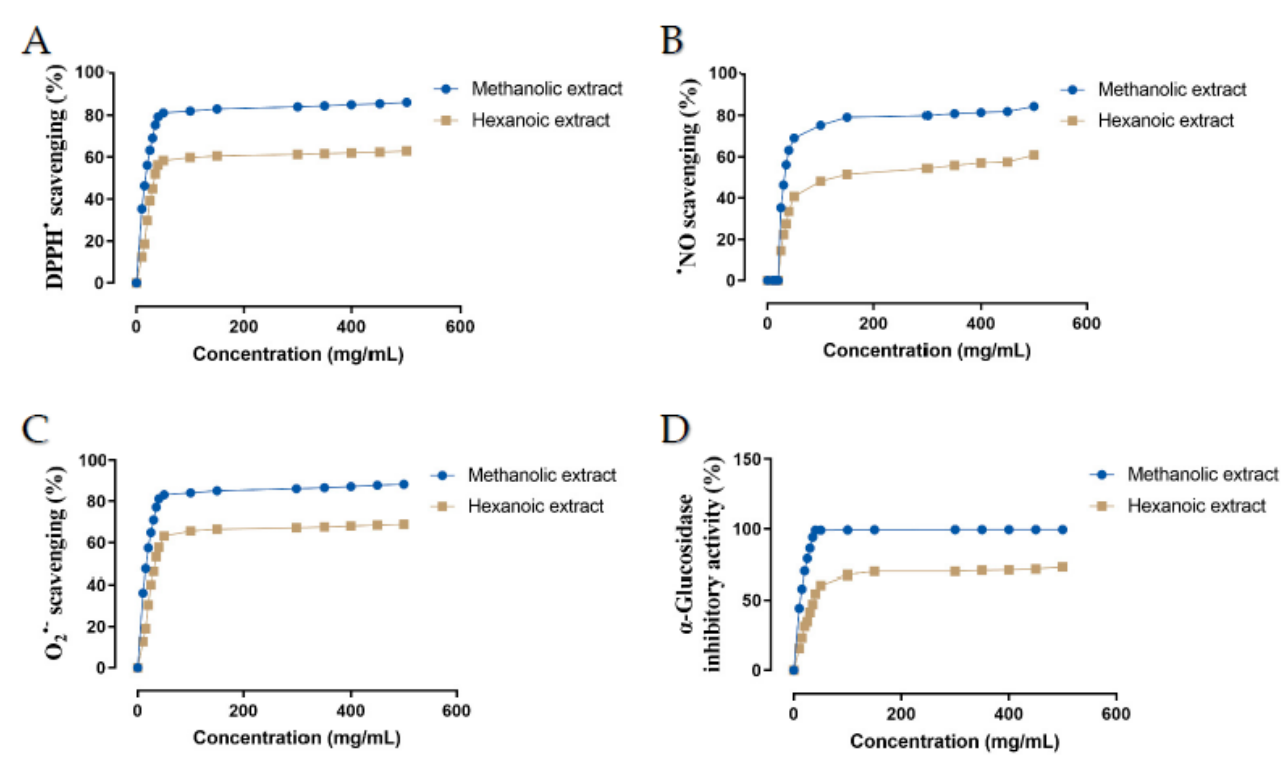
Figure 2. Effect of methanolic and hexanoic extracts of Farang ( P. guajava L.) leaves against ( A ) DPPH • : 1,1-diphenyl-2-picrylhydrazyl; ( B ) O 2•− : superoxide; ( C ) • NO: nitric oxide; ( D ) α-gluco- sidase. Table 3. IC 50 (mg/mL) values found in the antioxidant activity, α -glucosidase, hemoglobin oxidation, lipid peroxidation and hemolysis assays for Farang ( P. guajava L.) leaves.